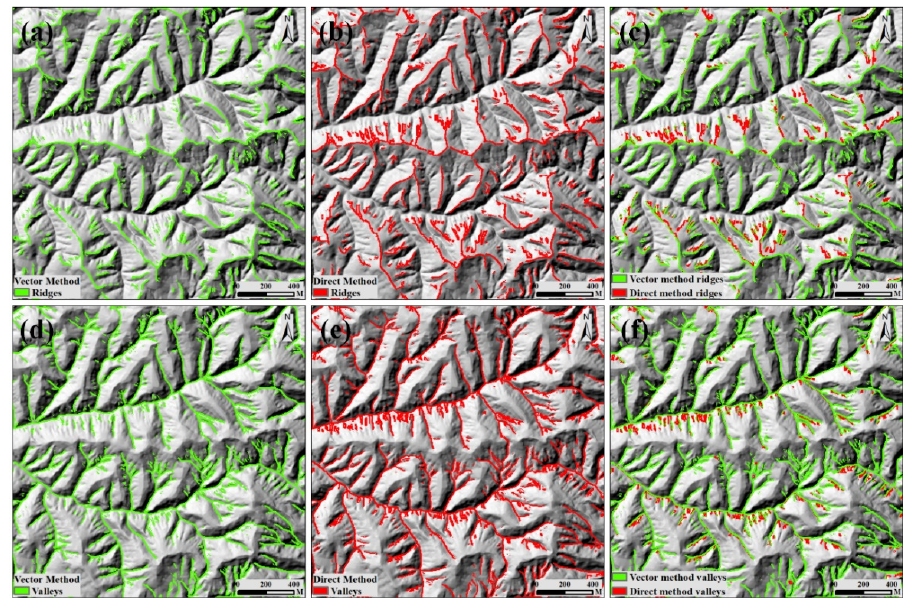
Figure 15. Extraction of ridges and valleys using the SoA derived from the direct and vector methods. Ridge extraction using the ( a ) vector and ( b ) direct methods and ( c ) the stacked results of both methods. Valley extraction using the ( d ) vector and ( e ) direct methods and ( f ) the stacked results of both